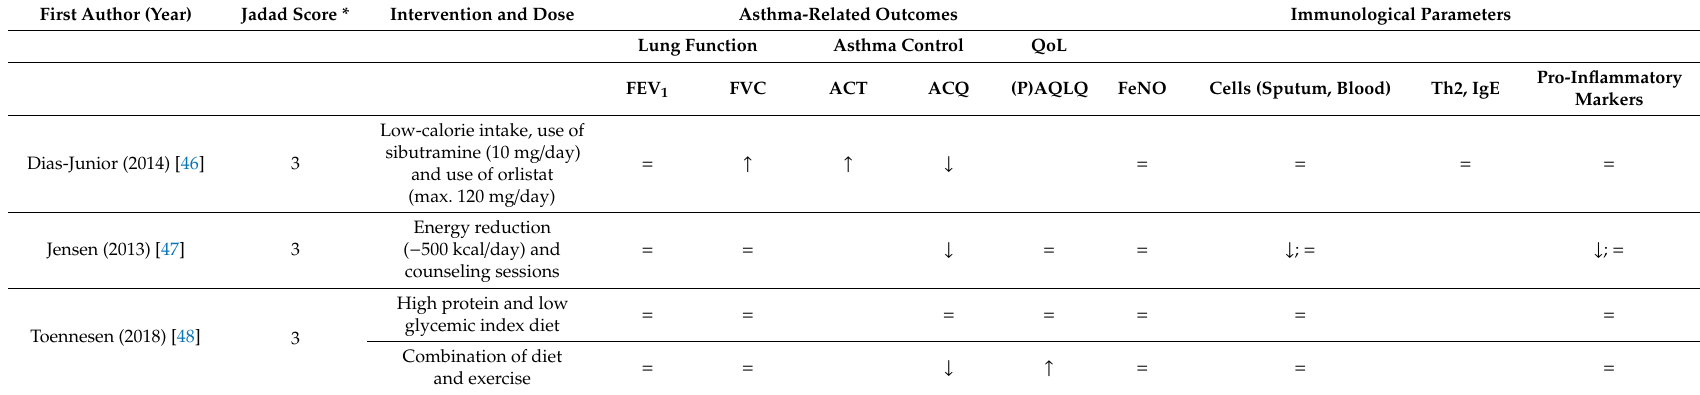
Table 4. Changes in asthma-related outcomes and immunological parameters as compared to the control group for the weight loss